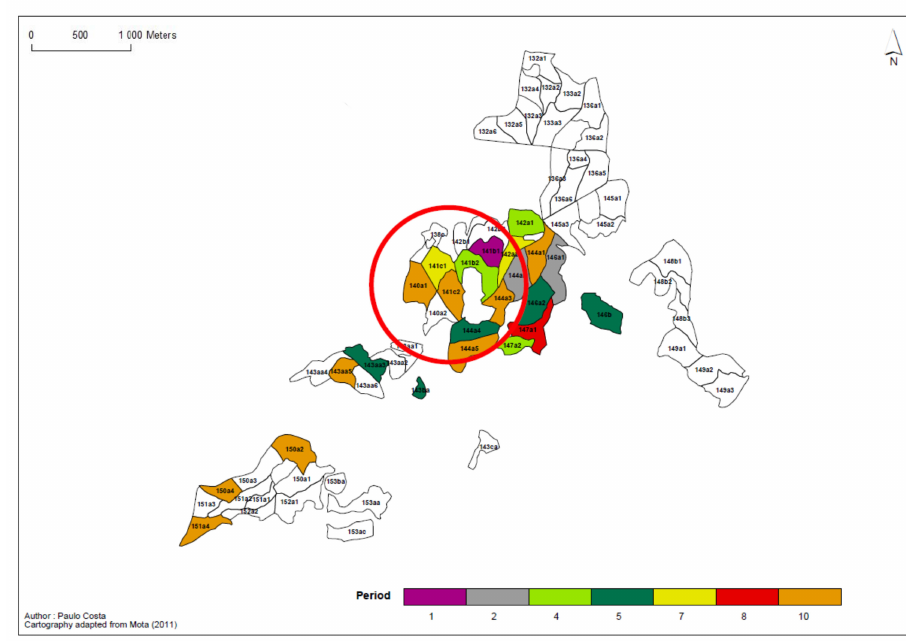
Figure 6. Map of clear cuts to be carried out for periods 1 to 10 of the planning